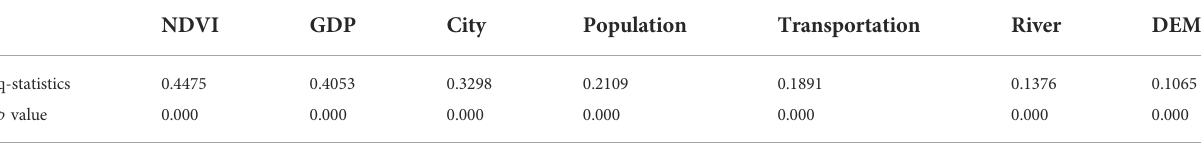
TABLE 2 Q-statistics table for the correlations between the various factors and the spatial distribution of scenic spots in Northwest China based on geographic detectors (scale size: municipal